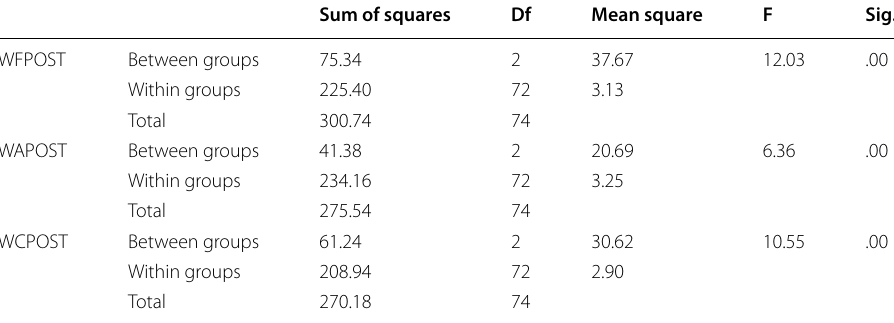
Table 9 Inferential statistics of all groups on the posttests of writing accuracy, fluency, and complexity Sum of squares